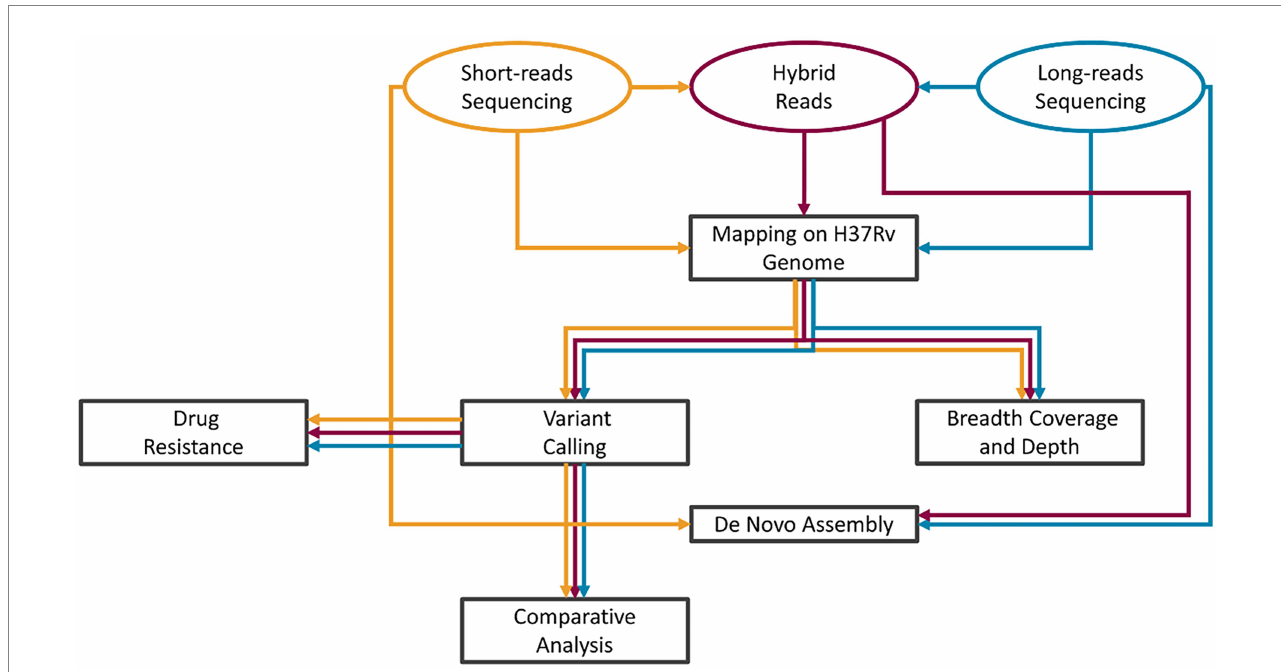
FIGURE 1 Bioinformatic analysis scheme. SRS pipeline workflow in yellow, LRS in blue, and HYBR in Red. After the acquisition of the short- and long-reads sequencing, hybrid long reads are produced. The tasks of the analyses were then performed in parallel starting from each of the three types of